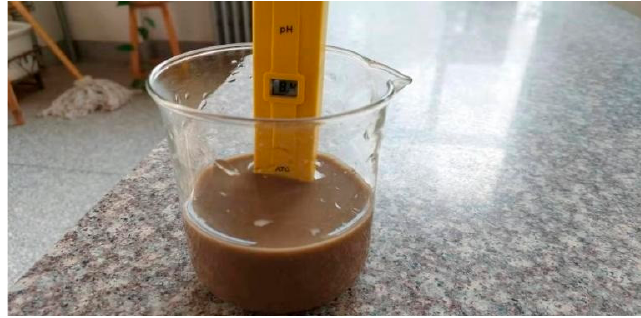
Figure 3. Determination of pH value.